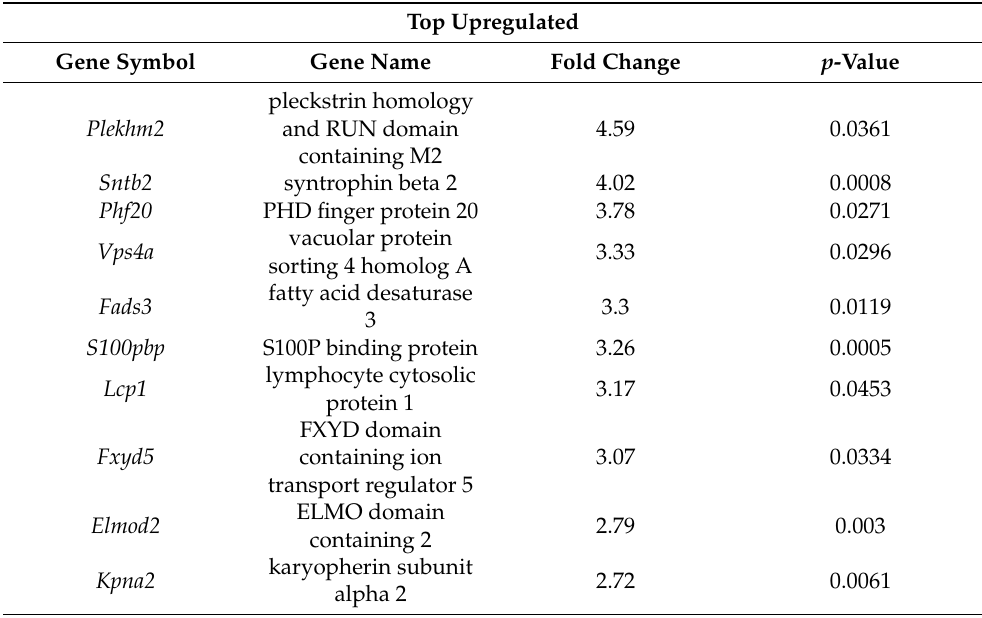
Table 1. Top differentially expressed genes in BAT of Trsp f/f -Ucp1-Cre +/ − - mice at room temperature.